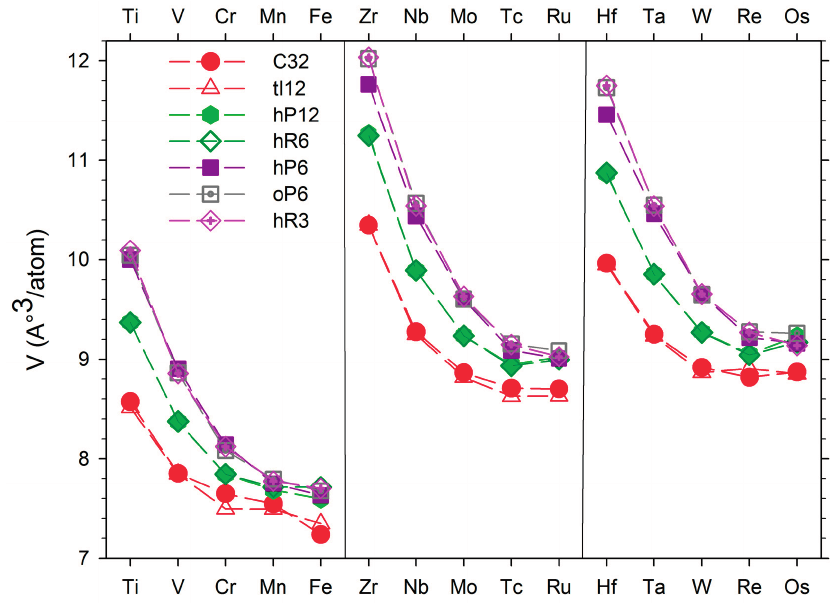
Figure 2. Atomic volumes of the TMB 2 compounds in the hP3 (AlB 2 -type), tI12 ( α -ThSi 2 -type), hP12 (WB 2 -type), hR6 (MoB 2 -type), hP6 (ReB 2 -type), oP6 (RuB 2 -type), and hR3 (CaSi 2 -type) structures.